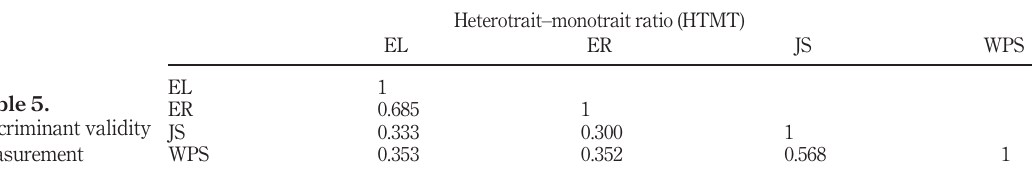
Table 5. Discriminant validity measurement